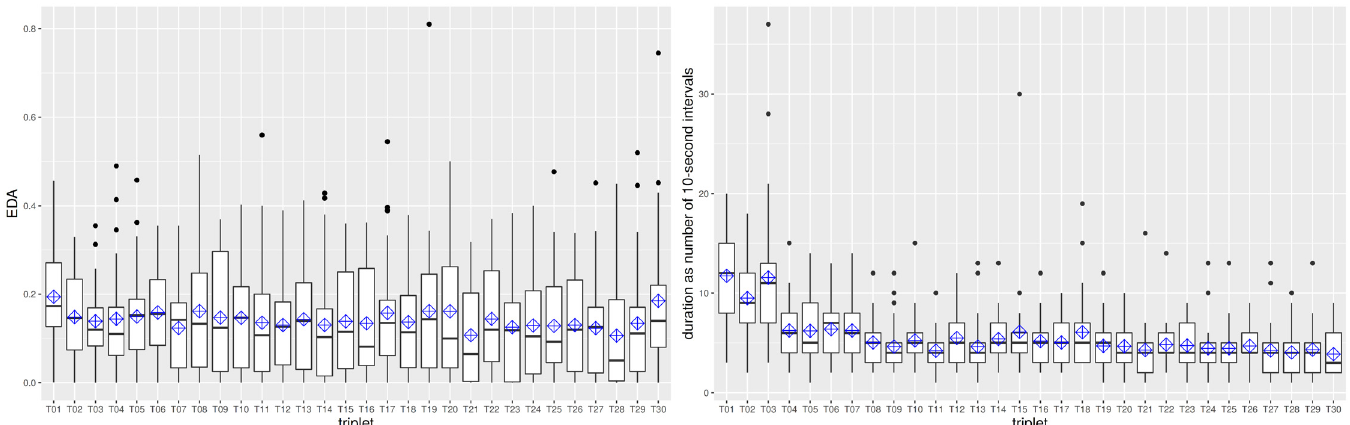
Fig 2. Boxplots of EDA (left subfigure) and of duration (right subfigure) with one box per triplet. The order of the triplets did not have any evident effect on EDA but had an effect on